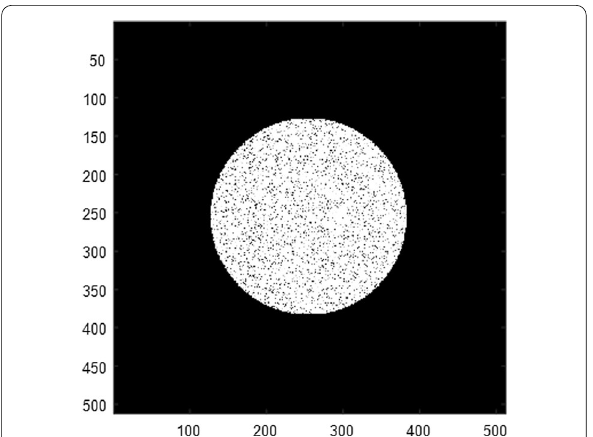
Fig. 4 The diffuser d ( u , v ) plotted in Fig. 2 obstructed by a circular uniform aperture of radius 128 pixels is shown